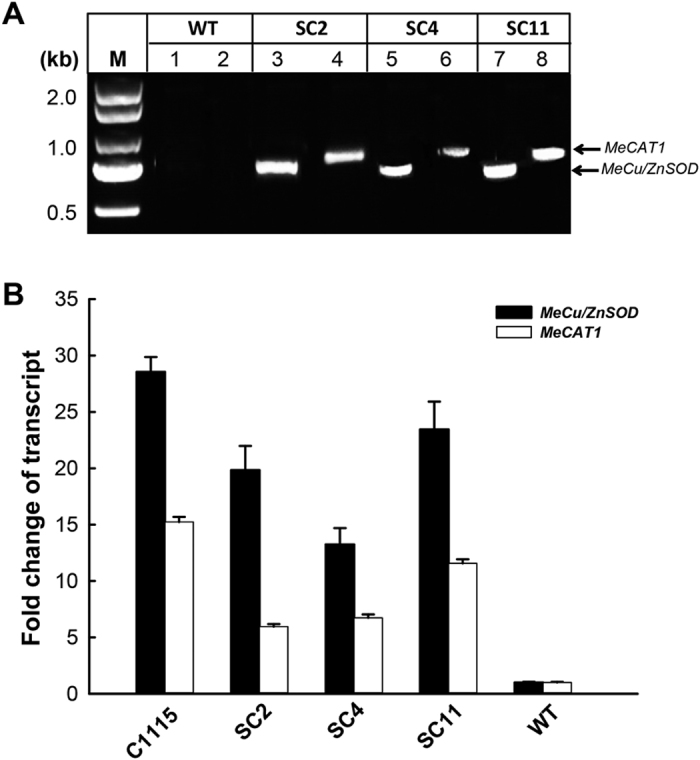
Molecular detection of transgenic cassava stability.(A) PCR products of MeCu/ZnSOD and MeCAT1 as presented on 1% agarose gel. Lane M: DNA standard ladder (DL-2000); lanes 1, 3, 5, and 7: PCR products were amplified using genomic DNA of wild type (WT), SC2, SC4, and SC11 as templates, respectively, and primers were specific for MeCu/ZnSOD; lanes 2, 4, 6, and 8: PCR products were amplified using genomic DNA of WT, SC2, SC4, and SC11 as templates, respectively, and primers were specific for MeCAT1. (B) qRT-PCR analysis of transcript levels of MeCu/ZnSOD and MeCAT1 in both transgenic cassava lines and WT. The relative transcript levels of MeCu/ZnSOD and MeCAT1 in the WT were set as 1.0, and the transcript levels were presented as the ratios of MeCu/ZnSOD and MeCAT1 in transgenic cassava lines, WT and C1115.